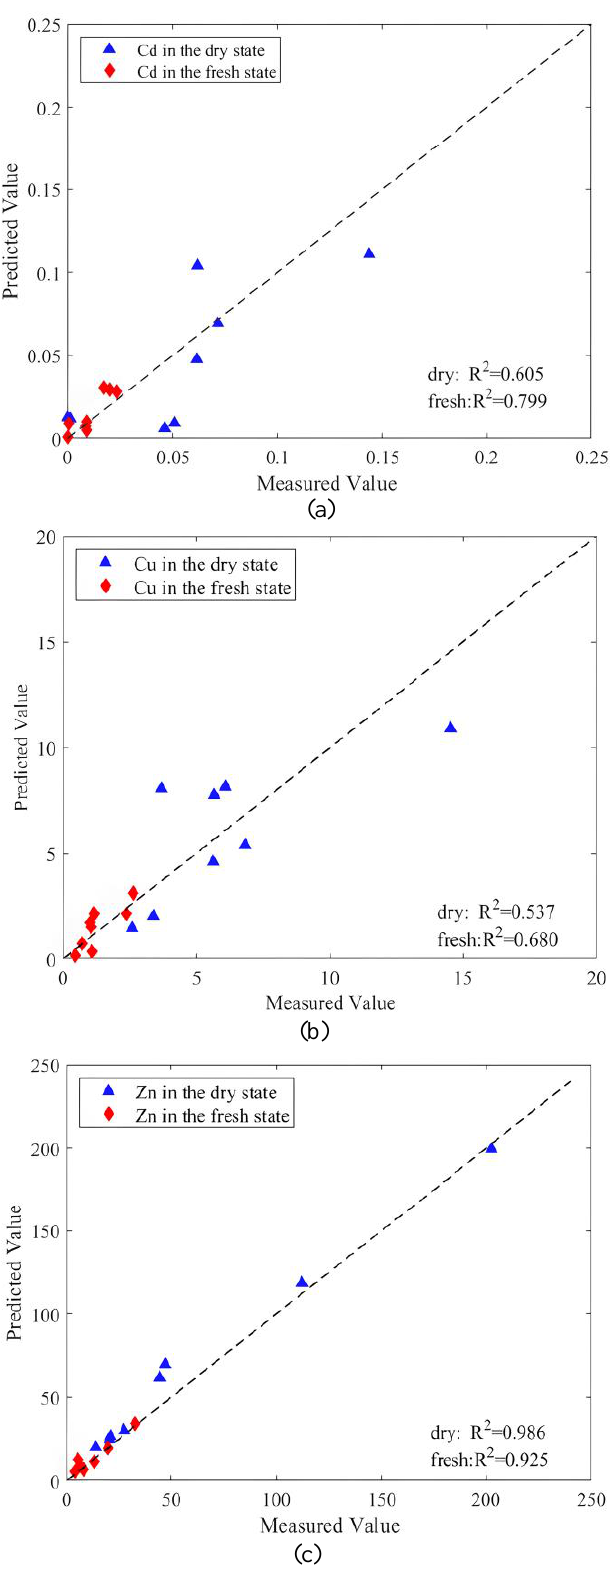
Figure 8. Validation results of a better estimation model for relative heavy metal content: ( a ) Validation results of Cd; ( b ) Validation results of Cu; ( c ) Validation results of Zn